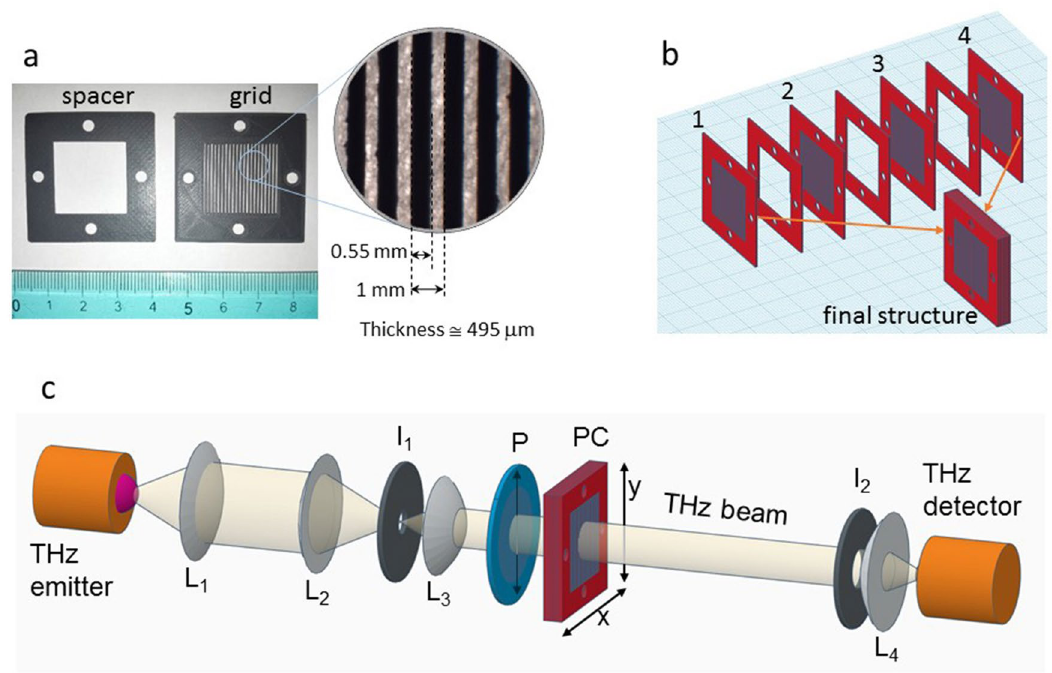
Figure 4. ( a ) The spacer and the grid, the 3D printed elements of the fabricated multilayer structures with their mean sizes. ( b ) The assembly of grids and spacers to build a structure made of a square lattice of rods with 4 layers. Other structures were assembled with 1 to 14 layers of rods. ( c ) Sketch of the THz beam line used for the experiments (see main text for